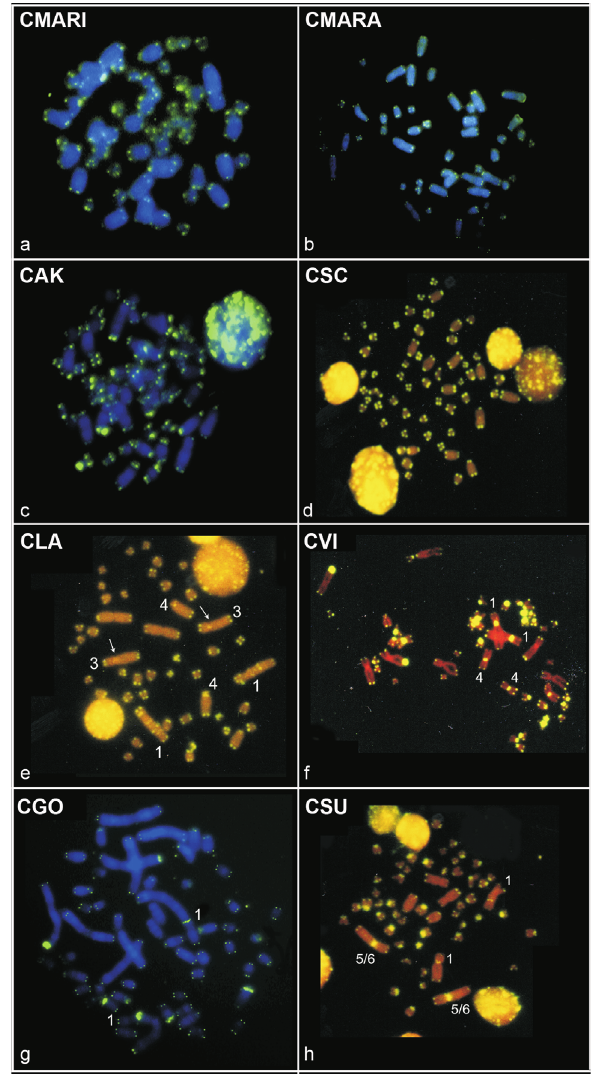
Figure 2 - FISH with telomeric probes in Cerradomys species: (a) C. marinhus – 2n=56, FN=54; (b) C. maracajuensis – 2n=56, FN=58; (c) C. akroai – 2n=60, FN=76; (d) C. scotti – 2n=58, FN=72; (e) C. langguthi – 2n=46, FN=56 (arrows indicate the ITS signals observed in pair 3); (f) C. vivoi – 2n=50, FN=64; (g) C. goytaca – 2n=54, FN=66 and (h) C. subflavus – 2n=54, FN=62. Chromosomes that bear ITS are